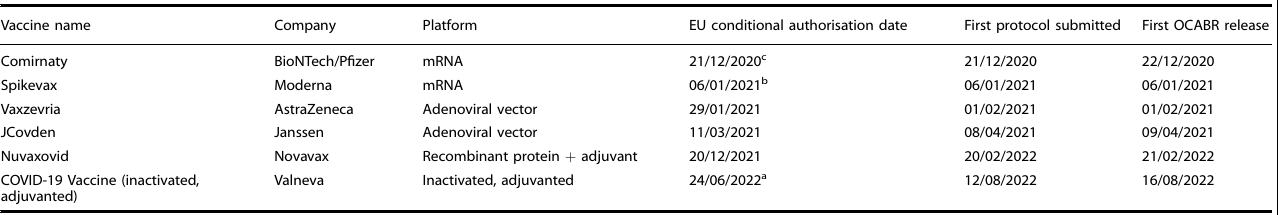
Table 1. Overview of COVID-19 vaccines licensed in the EU as of 01/07/2022 with conditional authorisation and fi rst release